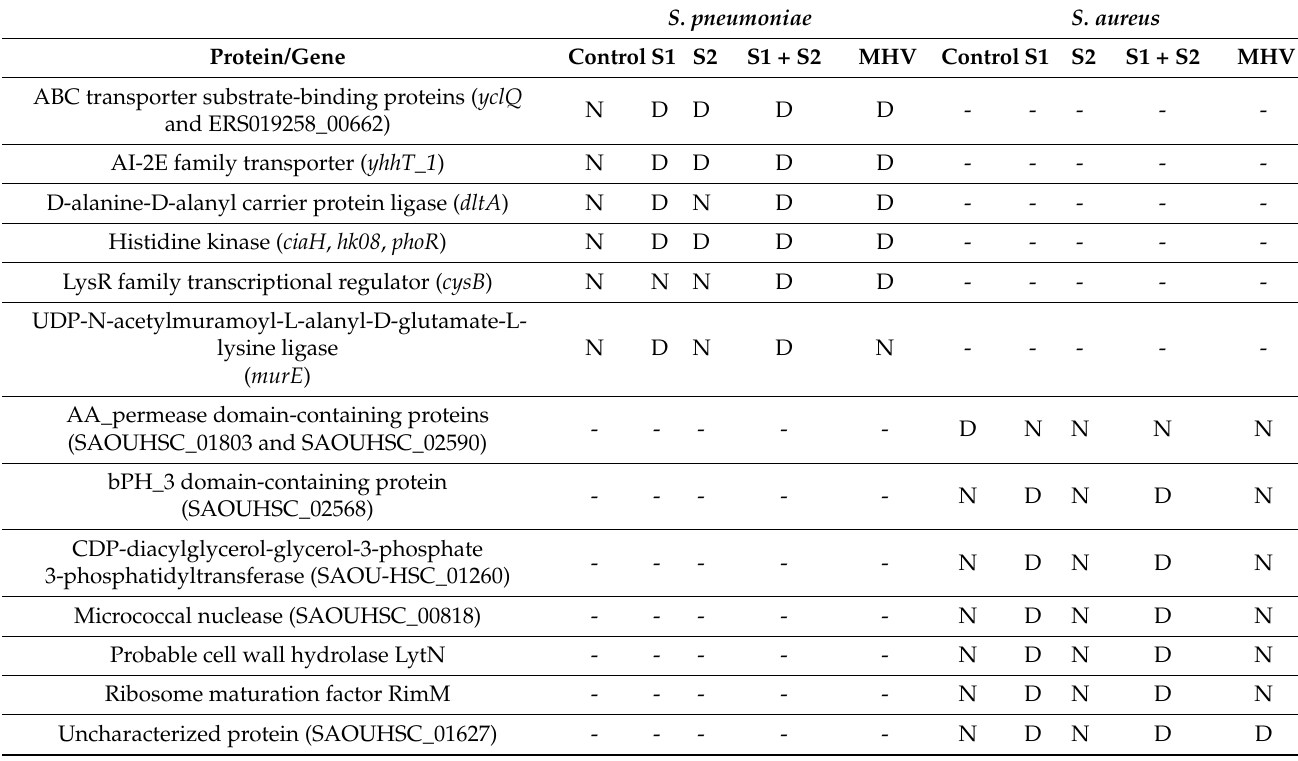
Table 2. Proteins of interest detected by LC-MS for proteomic analyses of bacterial and coronavirus interactions.